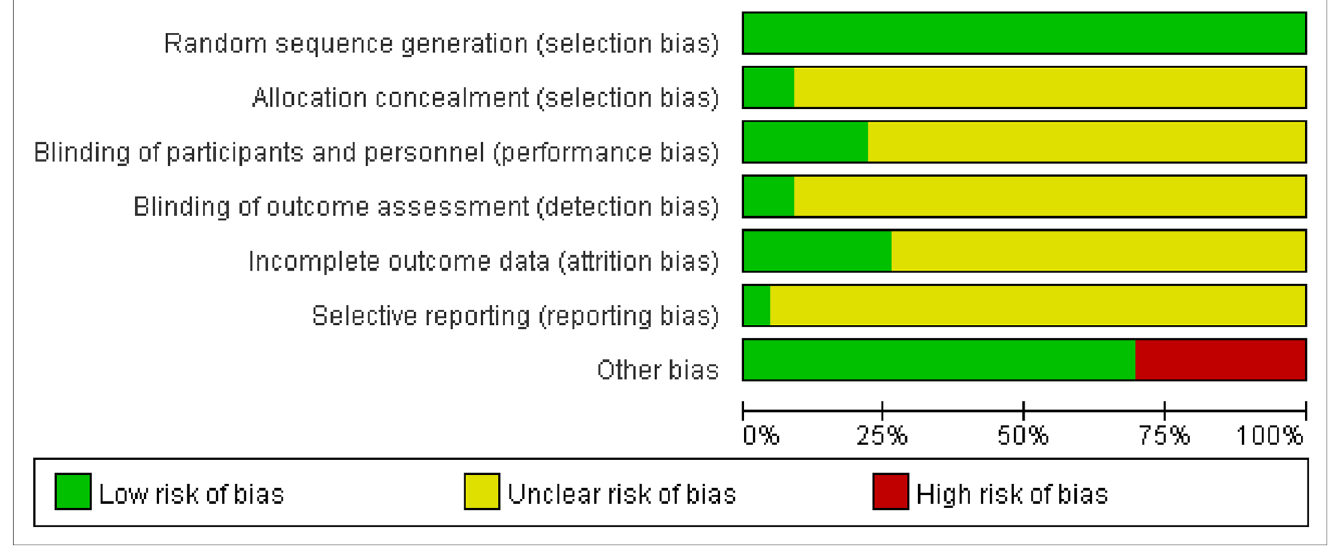
Fig 8. Risk of bias summary of included